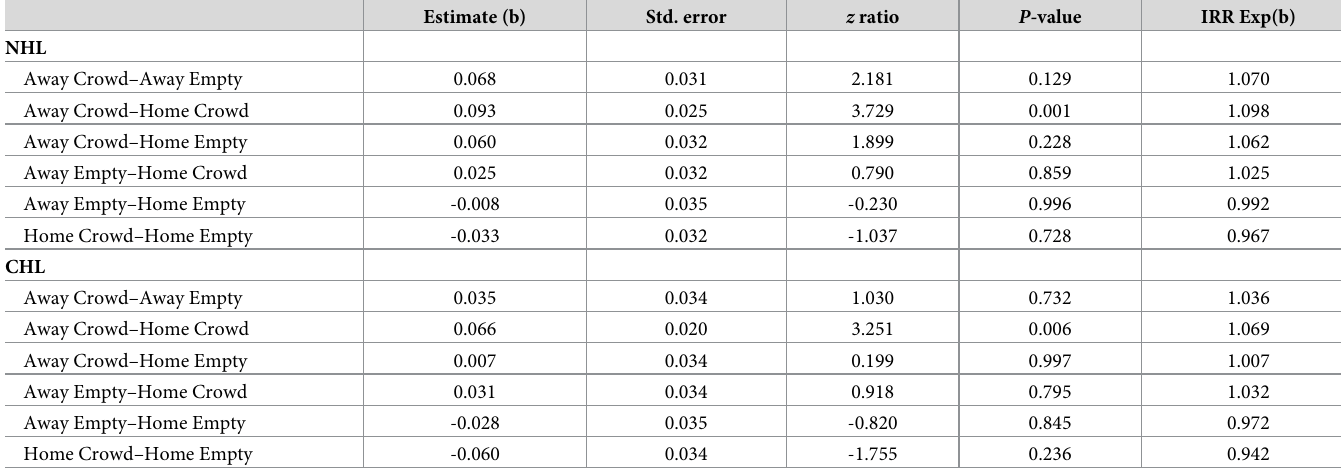
Table 6. Post-hoc results of the NHL ( n = 3278) and CHL ( n = 3418) models during regular